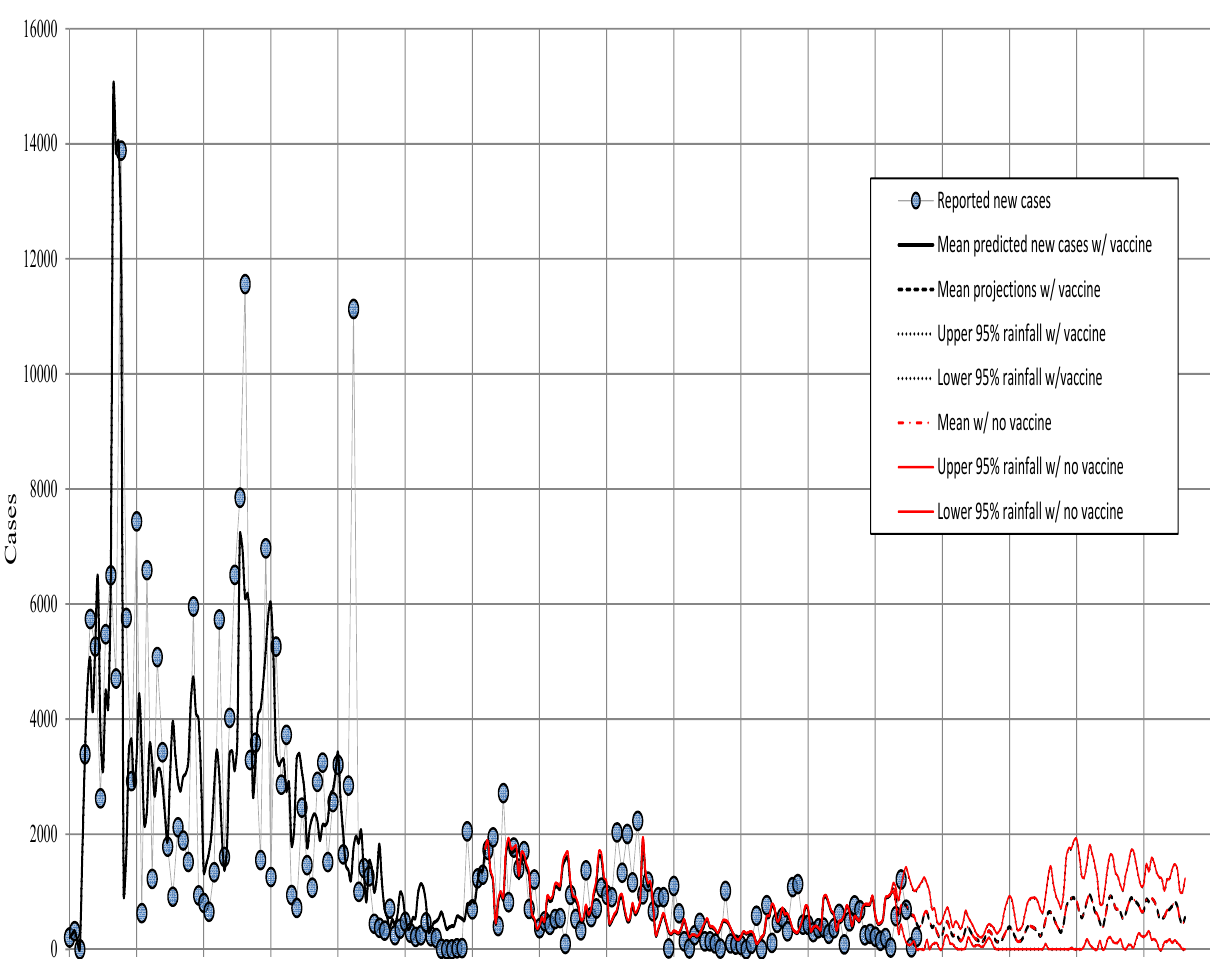
Figure 5. Ouest. The new symptomatic individuals vs . time. Circles, observed; solid line, model prediction; dashed lines, fifth, 50the and 95th percentiles for model projections based on the past 13 years of precipitation